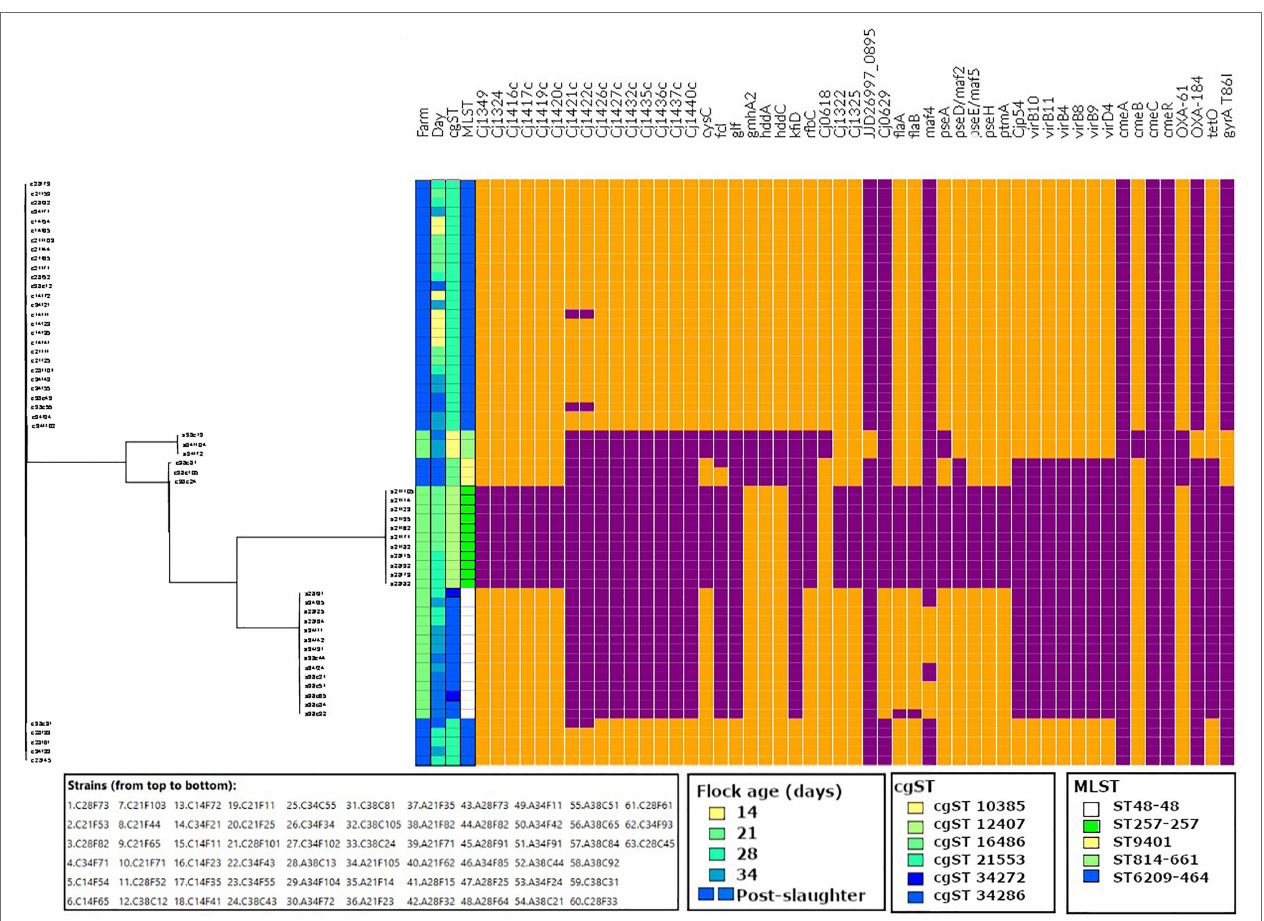
FIGURE 4 | Virulence ( Cj1349 – virD4 ) and antimicrobial resistance ( cmeA – gyrA T86I) profiles of the strains isolated in this study, aligned to the tree output from Roary. Data visualised on Phandango (http://jameshadfield.github.io/phandango/#/). Farm 1: green; Farm 2: blue. Present: orange; absent: